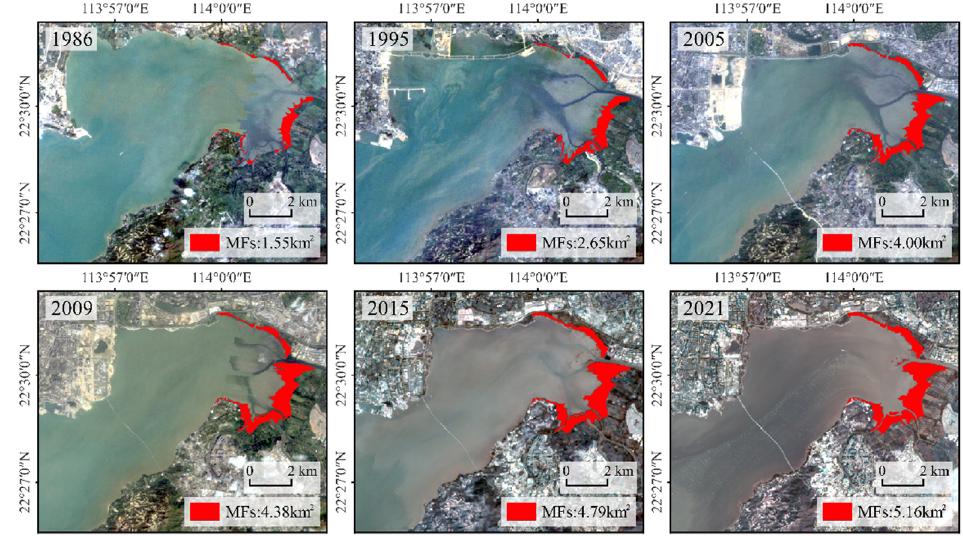
Figure 12. Inter-annual changes of the location and distribution of mangrove forests (MFs) in the Shenzhen Bay from 1986 to 2021.